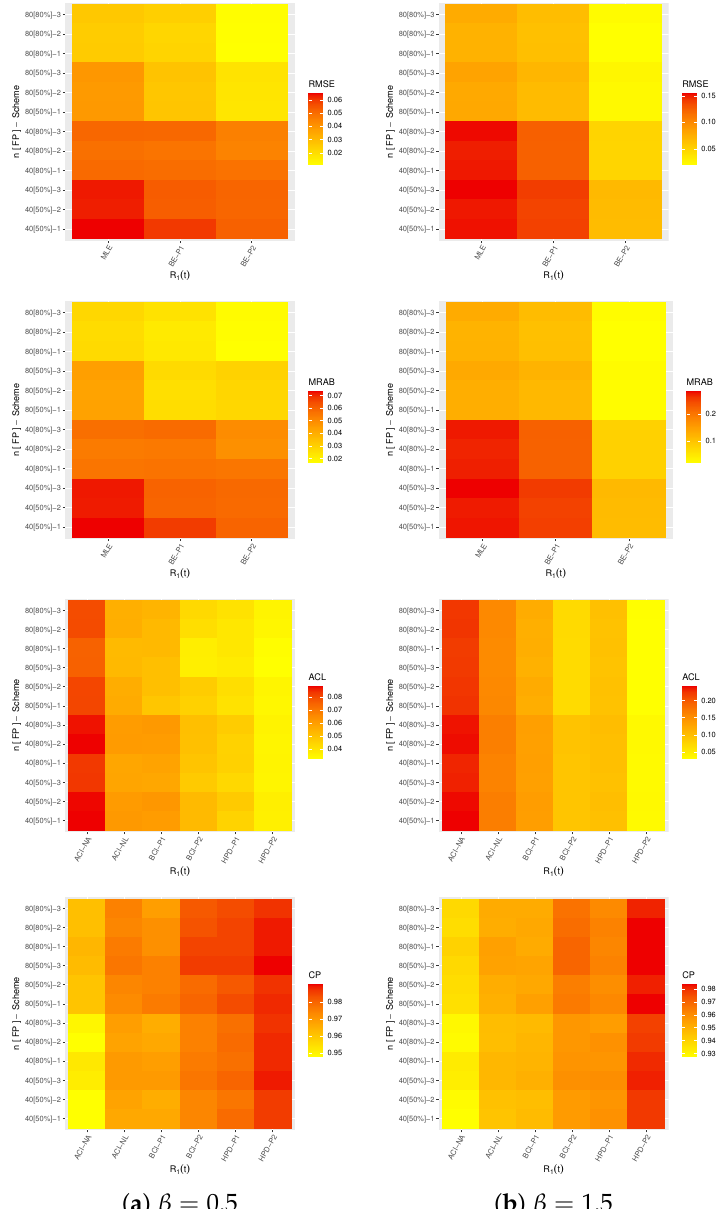
Figure 5. Heat-map for the Monte Carlo results of R 1 ( t )